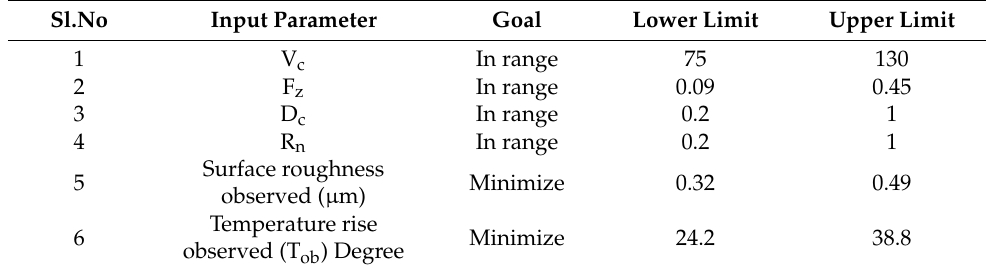
Table 6. Range of parameters and responses for desirability.